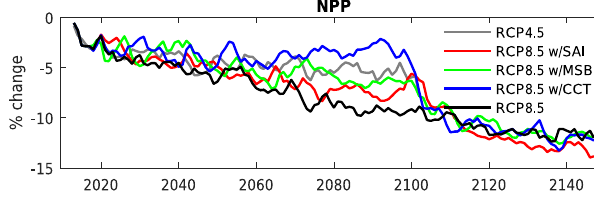
Figure 5. Time series of changes in global ocean NPP (%). The NPP change is relative to the 1971–2000 average in the historical